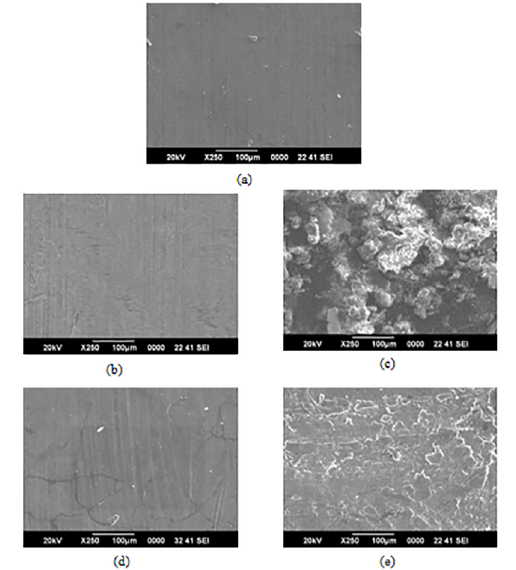
Figure 8. Al3003-O without deformation; 8b-c Deformed (Tool- blank contact)side of 0.1 mm and 0.7 mm step depth 8d-e: opposite to deformed side 0.1 mm and 0.7 mm step depth respectively. magnification of Al3003 without any processing, i.e. in plain condition is presented in Fig.9a.Figure 9b-c show the micrographs of base side the formed area with 0.1mm and 0.7mm step depth whereas Figure 9d-e is the micrographs of thickness side with 0.1mm and 0.7mm step depth of the formed pyramid respectively.